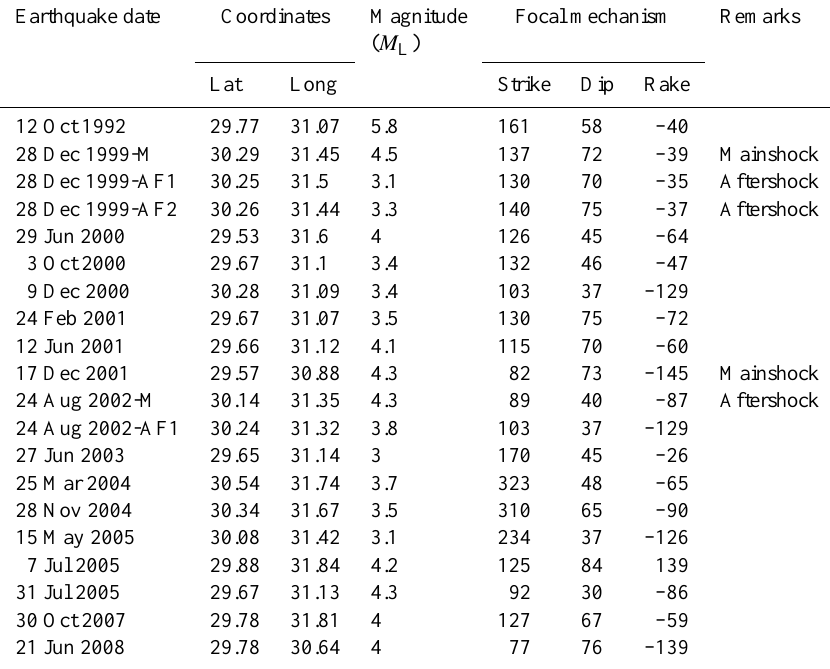
Table 1. Focal mechanism parameters of the earthquakes with magnitude greater than M L ≥ 3 which occurred in the effective sesimogenic zones in and around Greater Cairo